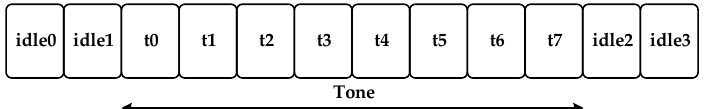
Figure 4. Diagram of the proposed time framing technique for narrowband sounding, where every slot is equal to 1 s.